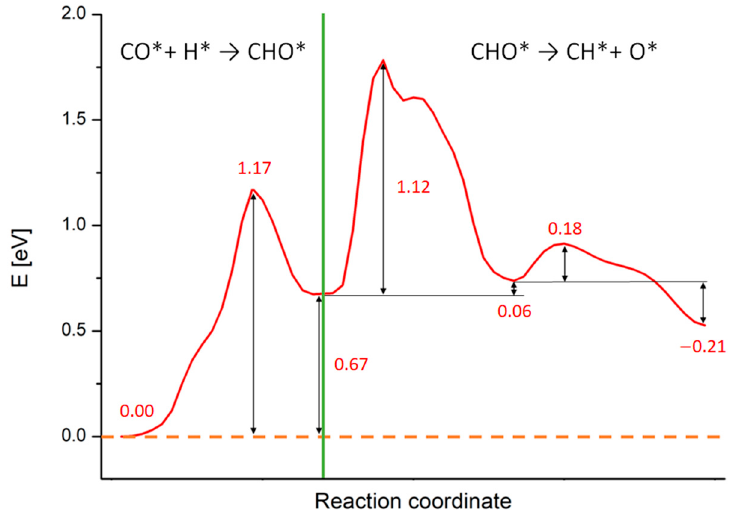
Figure 3. Reaction energy profiles for the whole CO* + H* → CH* + O* reaction on Rh (100) surface calculated at the PBE+U level. The numbers report the values of energy barriers and reaction energies in eV. The green line separates the two subprocesses in which we split the calculations: the CHO* generation starting from CO* and H and the CHO* dissociation in CH* and O*.